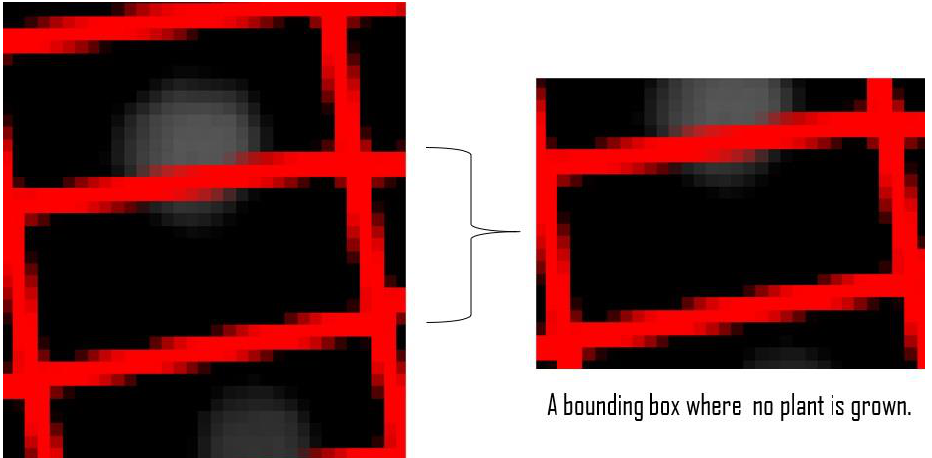
Figure 3. A bounding box without a plant, but due to the overlapping of the top plant, the bounding box contains some image pixels that are erroneously classified as plants.